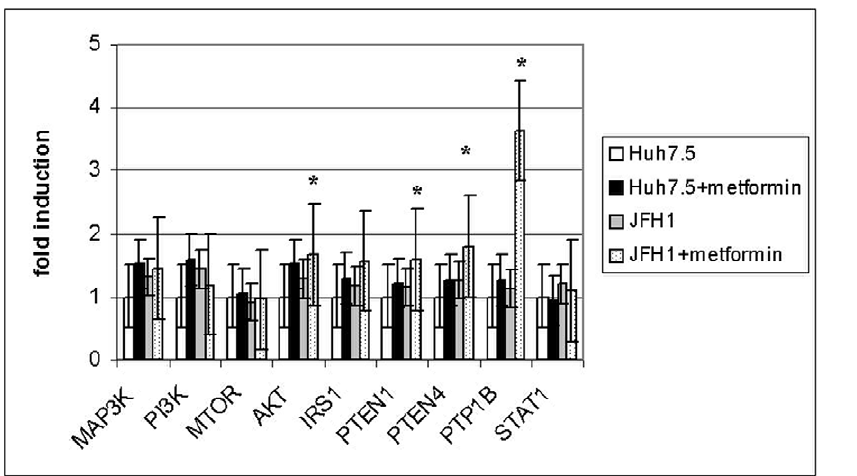
Figure 3. PTP1B is highly induced in the presence of metformin and HCV. Gene expression (fold induction) of insulin pathway-related genes in Huh7.5 cells treated with metformin (2 mM) was analyzed. Experiments were performed in triplicate. (*)=p , 0.05.